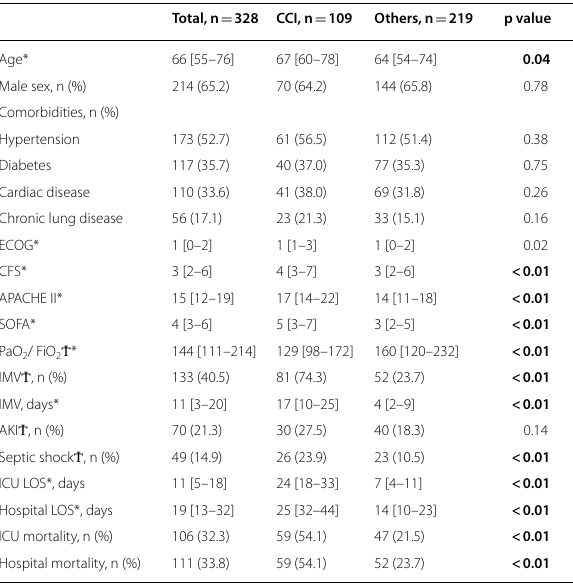
Table: General characteristics of patients with chronic critical illness and